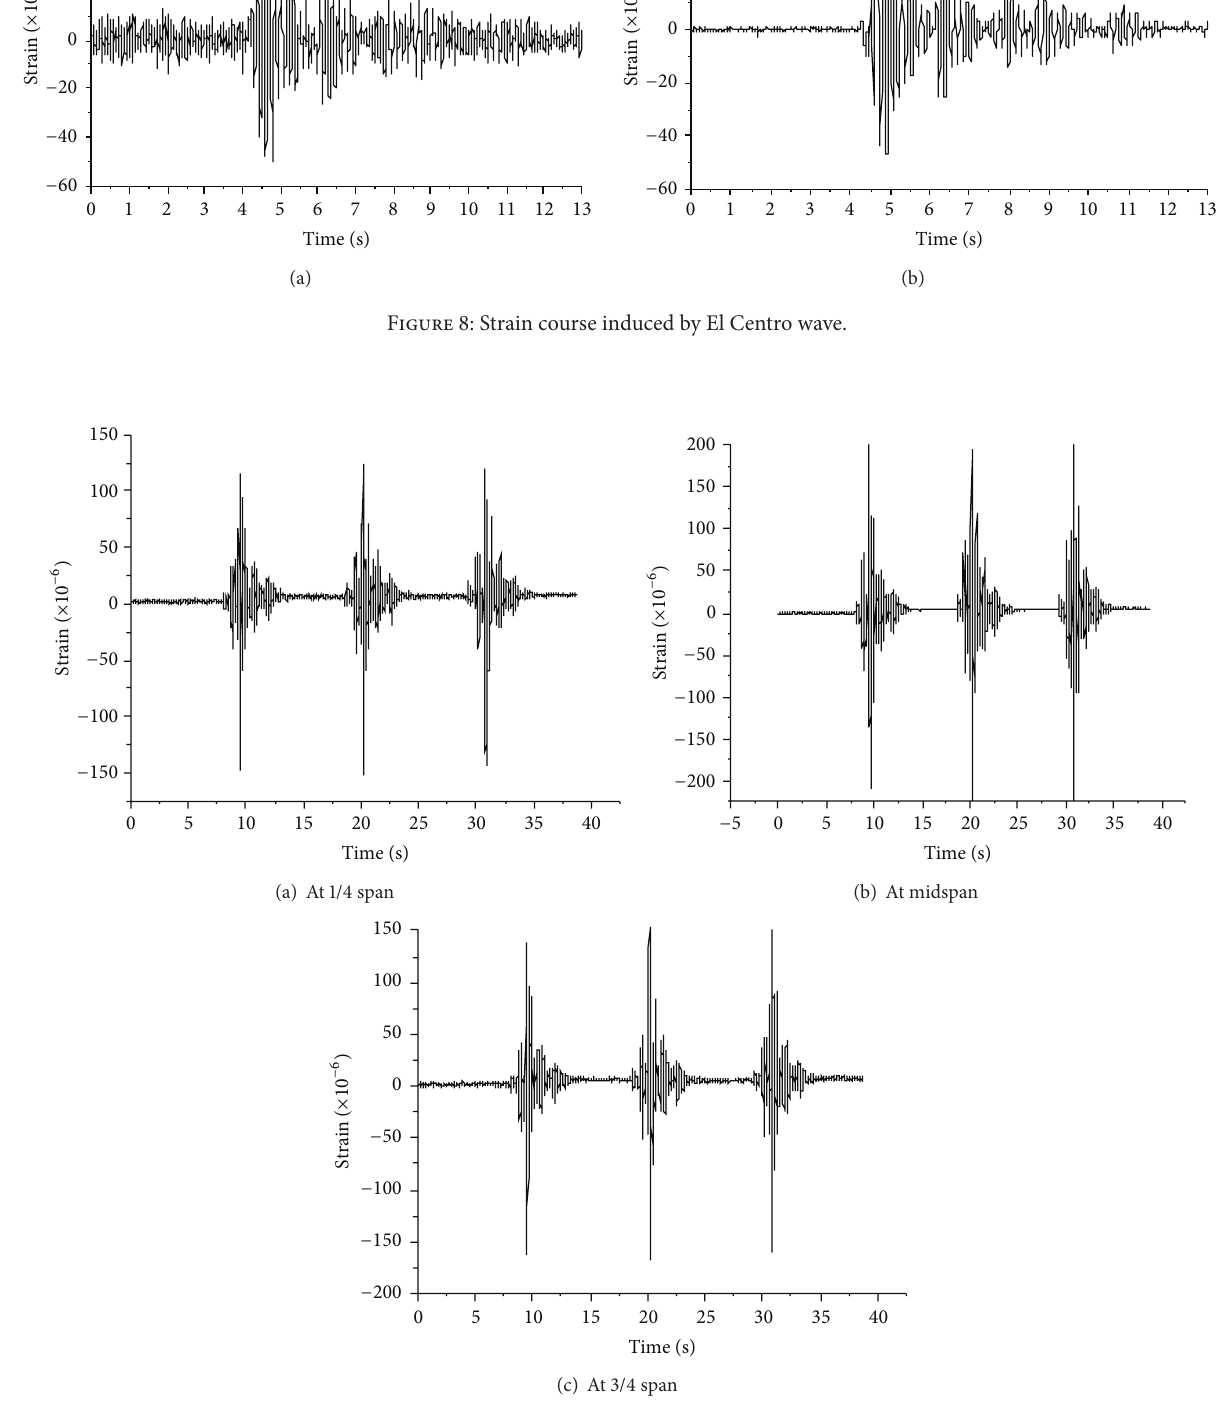
Figure 9: Strain course induced by Northridge